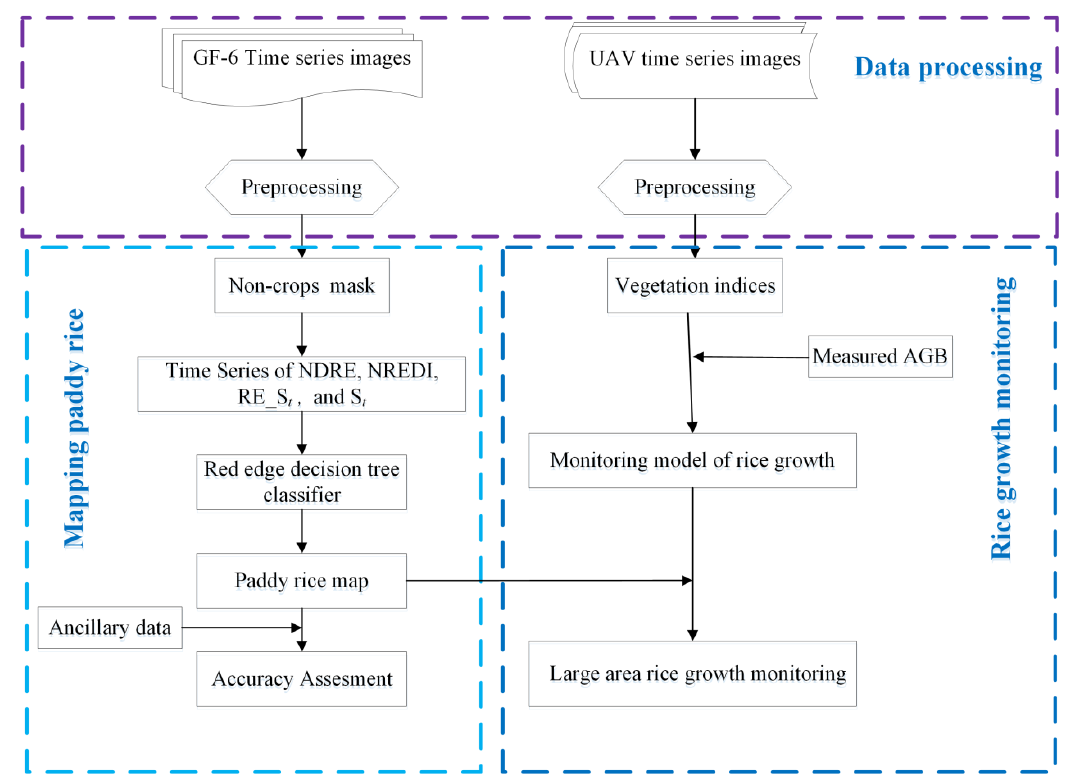
Figure 4. The flowchart of the methodology.